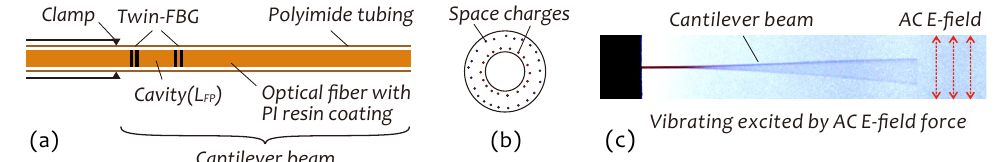
Figure 1. ( a ) A structure schematic of proposed sensor, ( b ) a sketch on space charge distributions inside PI tubing and ( c ) a photo of sensor vibrating in AC E